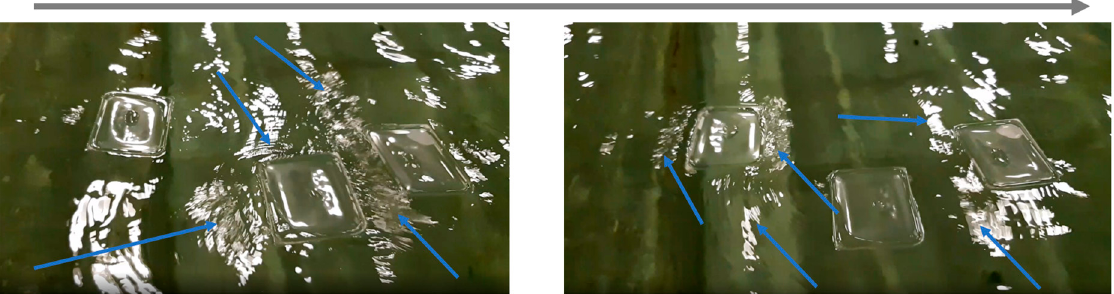
Figure 9. Still images from camera footage of the plastic lids moving on the water surface. The blue arrows highlight capillary wave generation from the objects interacting with the waves. The grey at the top of the fi gure indicates the direction of wave movement.